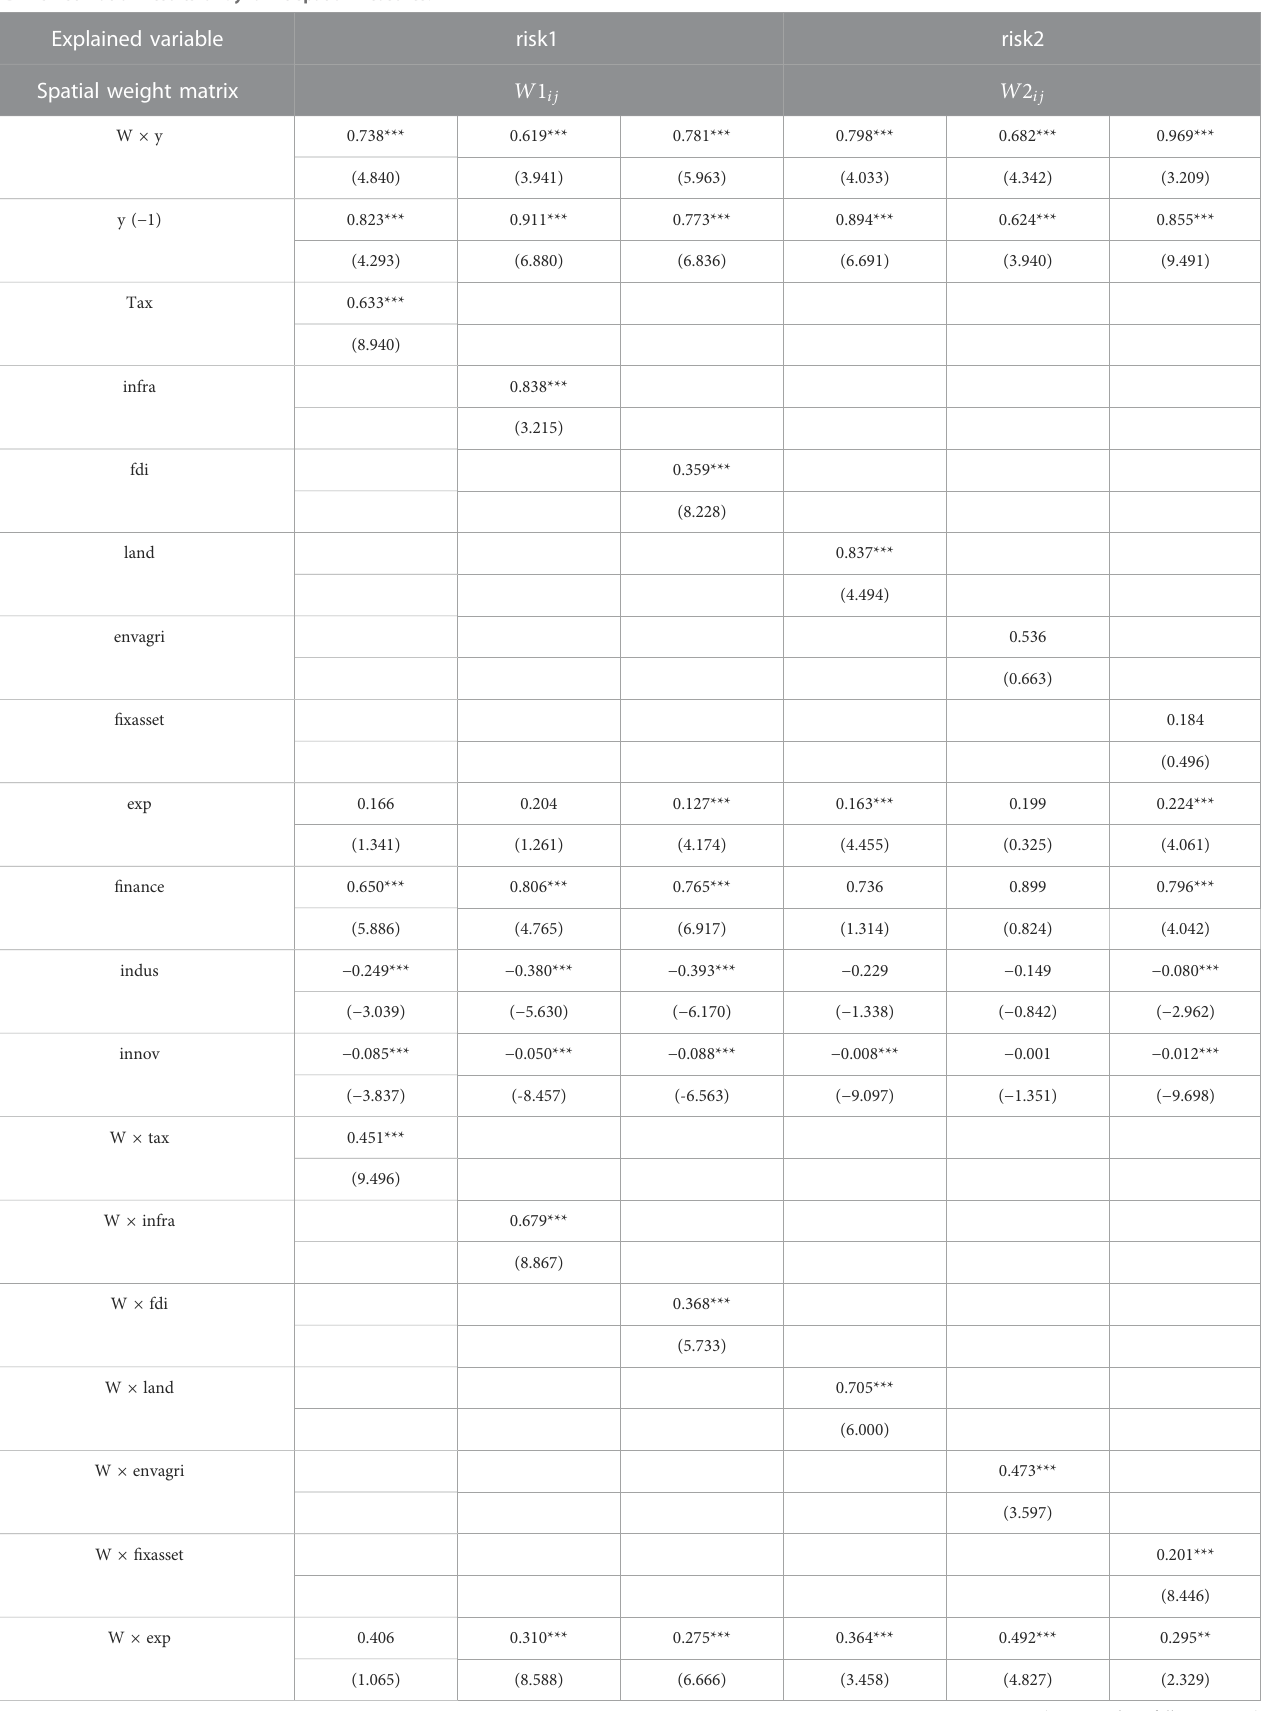
TABLE 5 Estimation results of dynamic spatial